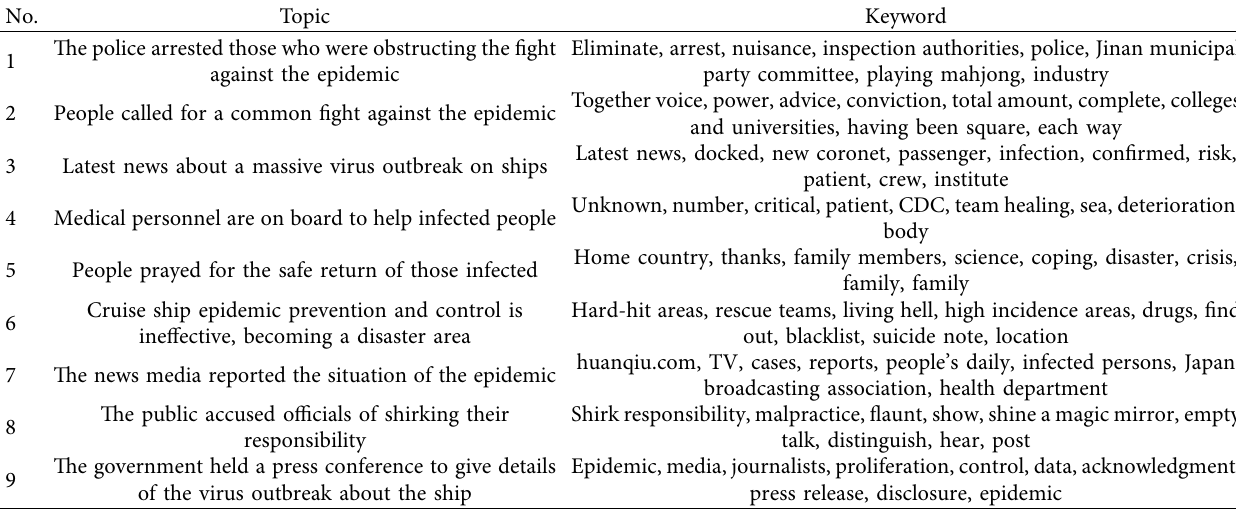
Table 2: Topic clustering of the public health emergency.